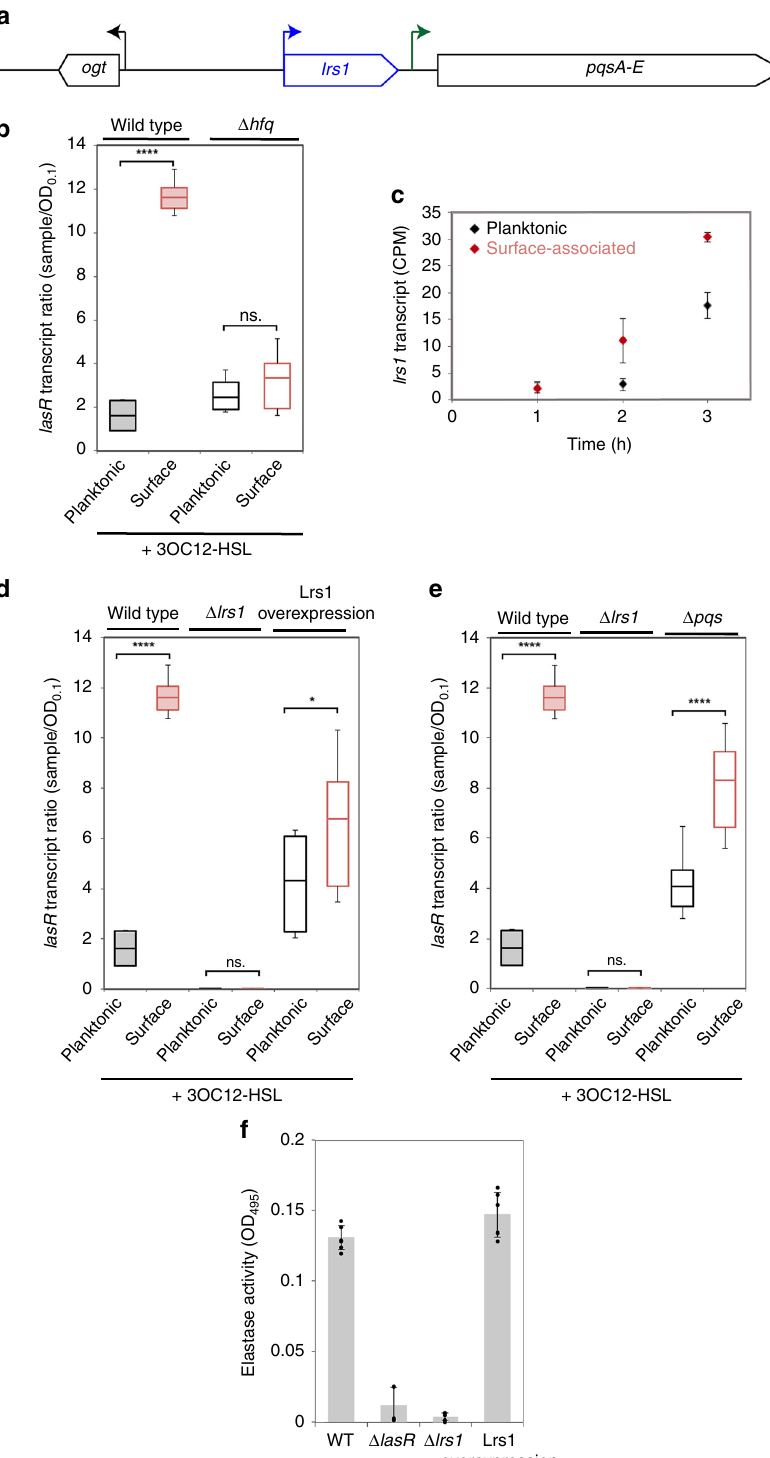
Fig. 3 sRNA Lrs1 is required for surface-primed QS. a Depiction of lrs1 location in the P. aeruginosa genome. b lasR transcript levels from qRT-PCR. c Lrs1 levels from RNA-seq data for planktonic and surface-attached cells. d lasR abundance by qRT-PCR in Δ lrs1 and upon Lrs1 overexpression. e lasR abundance by qRT-PCR in Δ pqsA-E . f Congo Red-Elastase assay comparing WT, Δ lasR , Δ lrs1 and Lrs1 overexpression. Individual data represented by black points ( n = 6). Error bars in plots represent standard deviation and boxes indicate 25/75 data with the center representing the mean. A two-tailed student ’ s t -test was performed to determine signi fi cance between samples and is denoted by asterisks ( n = 9) (ns. = no signi fi cance,* p < 0.01, **** p < 0.0001). Source data